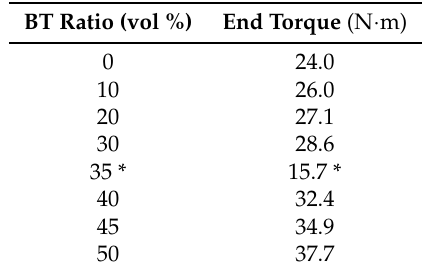
Table 1. Torque values for the composite feedstock at the end of the kneading step (* @210 ◦